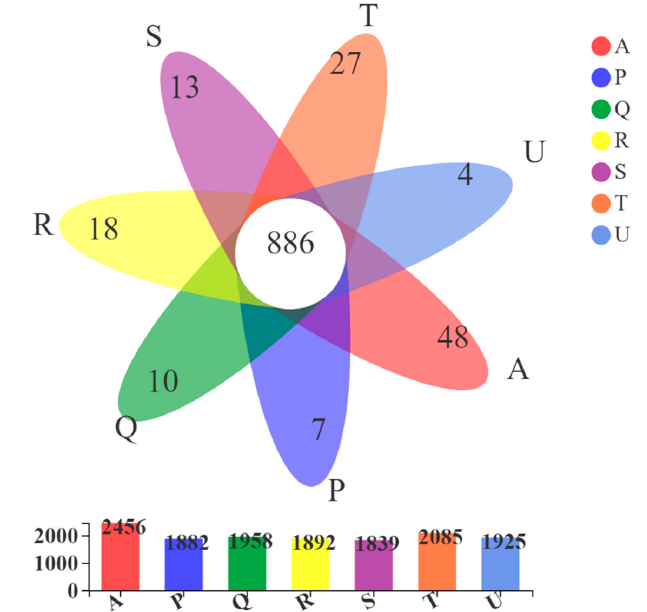
Figure 5. Number of unique and shared operational taxonomic units (OTUs) in the different groups.